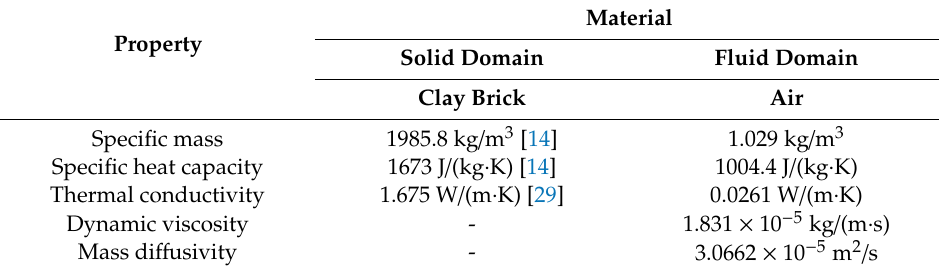
Table 1. Physical-chemical properties of the materials used in the simulations.